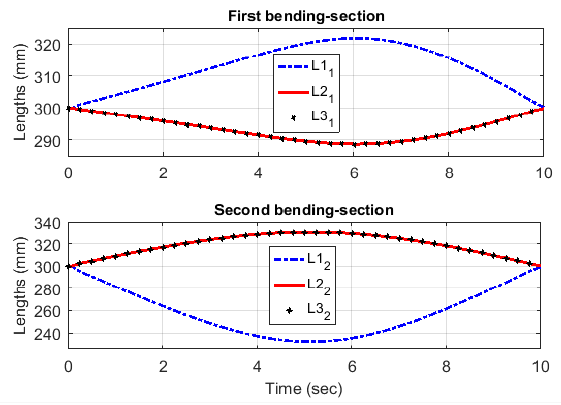
Figure 12. Evaluation of cable lengths for the kinematic NMPC-PSO